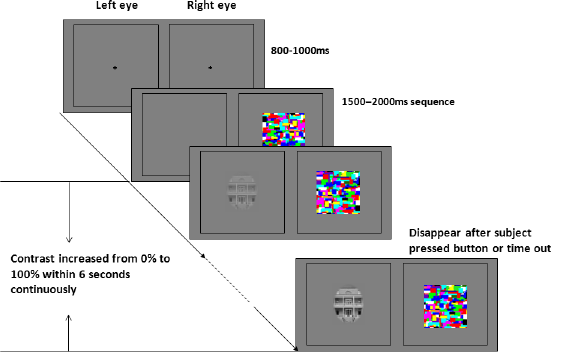
Fig 2. Schematic representation of the experimental paradigm: the contrast of the stimulus images increased continuously from 0% to 100% over a period of 6s. Subjects were instructed to press the space button as quickly as possible when they saw an image. Thus in our experiment, the breakthrough contrast was equal to the response time or duration of